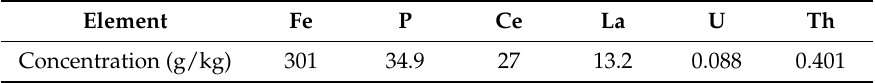
Table 1. Chemical composition of elements of the laterite ore evaluated in this study. Element Fe P Ce La U Th Concentration (g/kg) 301 34.9 27 13.2 0.088